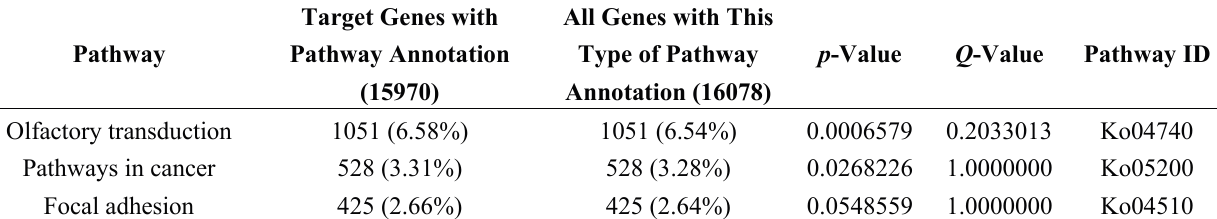
Figure 5. Gene ontology statistics. Table 3. Pathway